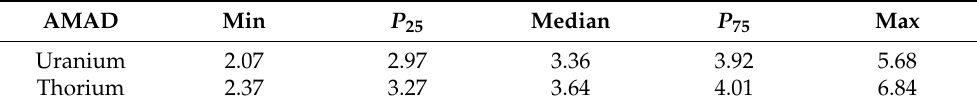
Table 1. Descriptive parameters of AMAD for uranium and thorium PM. AMAD